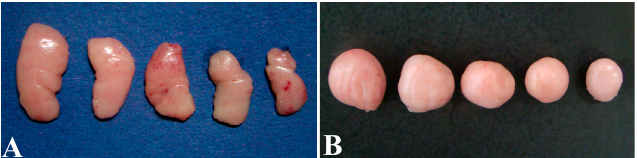
A B Figure 1. Gross changes in the size of the thymus ( A ) (first lobus on the right) and BF ( B ) of the chickens at 21 days of age. From left to right: organs in the control group, 25%, 50%, 75% and 100% groups.